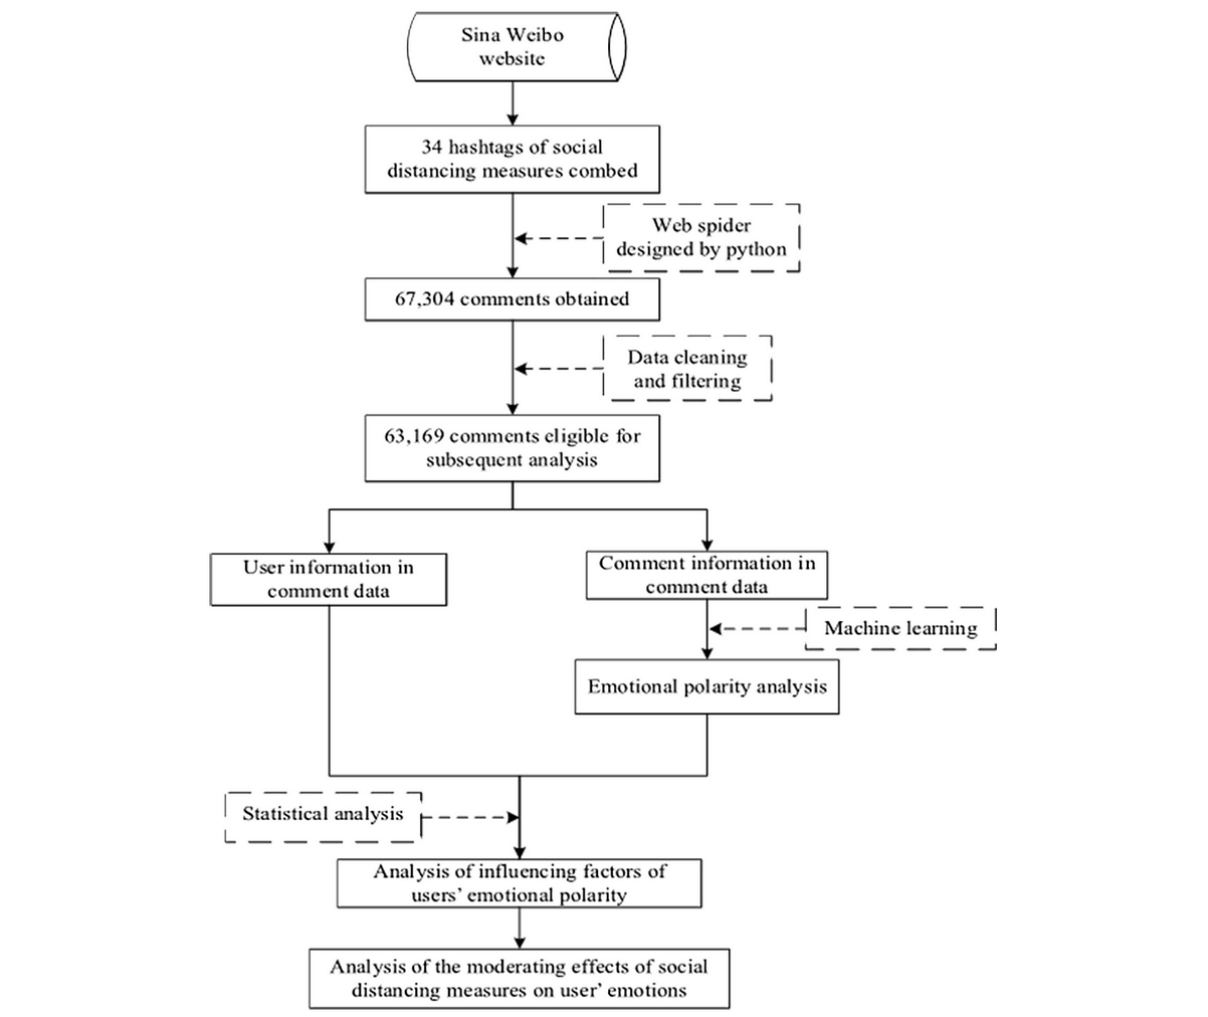
Figure 1. Flowchart for obtaining data from Sina Weibo for subsequent